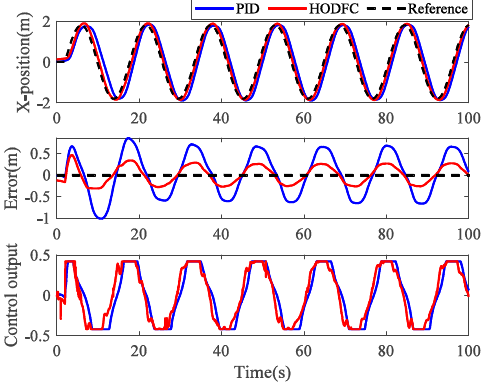
Figure 14. Experimental results of space spatial trajectory tracking in the x position.